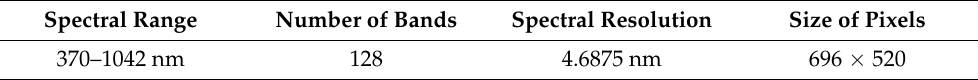
Table 2. Equipment Table 2. Equipment parameters.